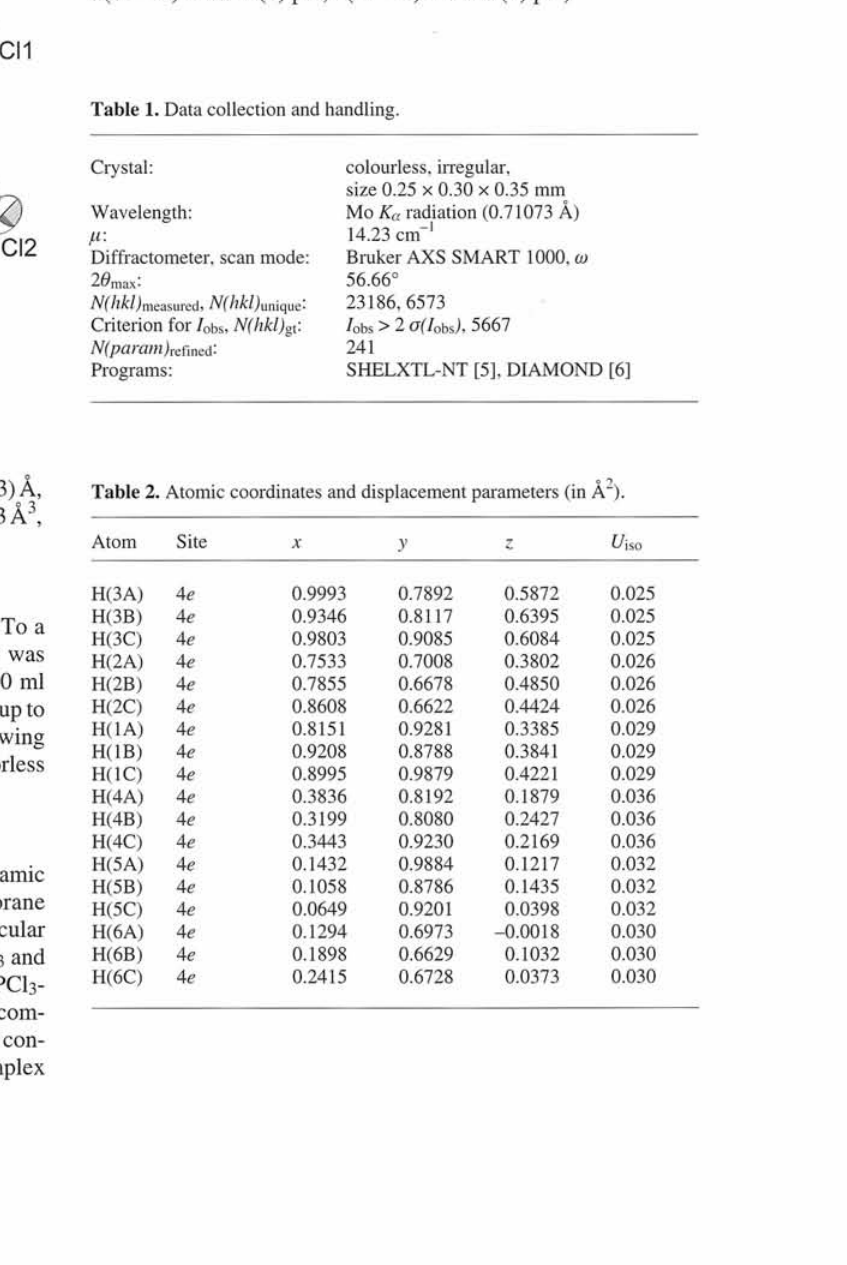
Table 1. Data collection and handling.